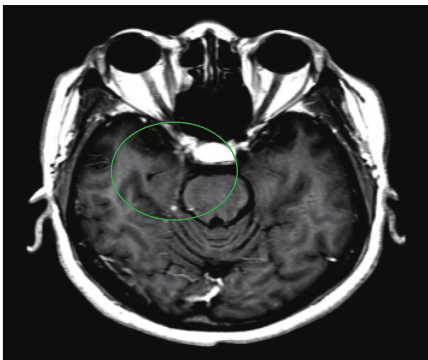
Figure 2: Subsequent cranial MRI showed resolution of the abnor- mal enhancement in the cavernous sinus area seen on the initial cranial